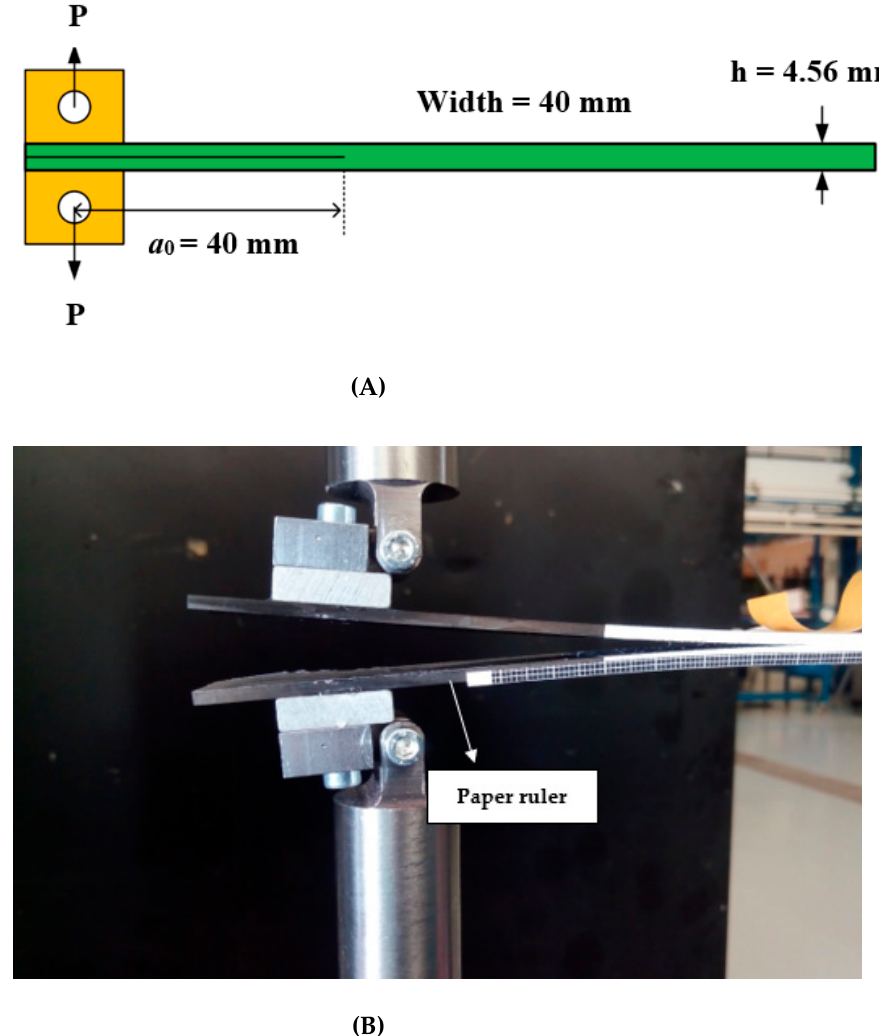
Figure 2. ( A ) DCB specimen characterizations; ( B ) mode-I experimental test